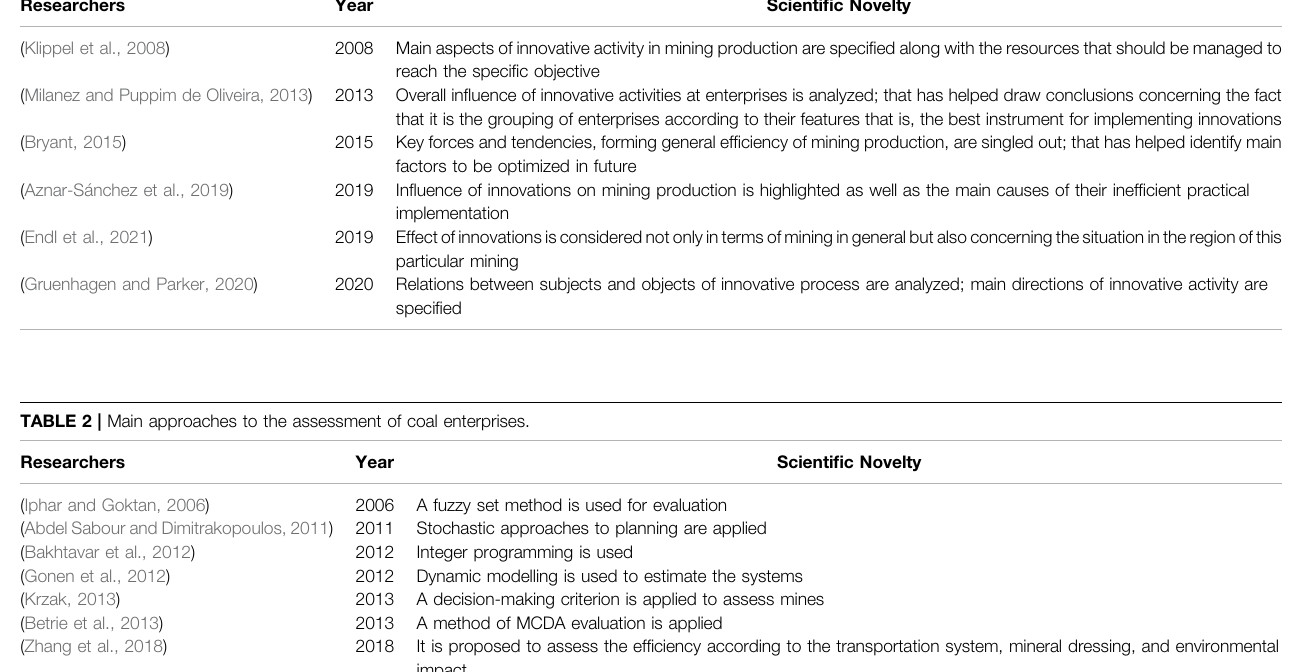
TABLE 1 | Analysis of publications dealing with innovation management and in fl uence of innovations on the mining ef fi ciency.